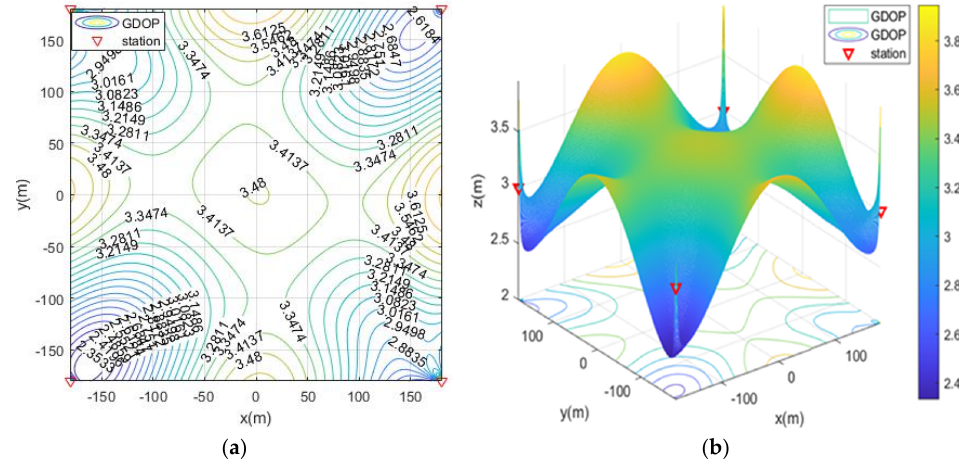
Figure 6. GDOP contour map without optimized station deployment. ( a ) 2D contour map; ( b ) 3D contour map.